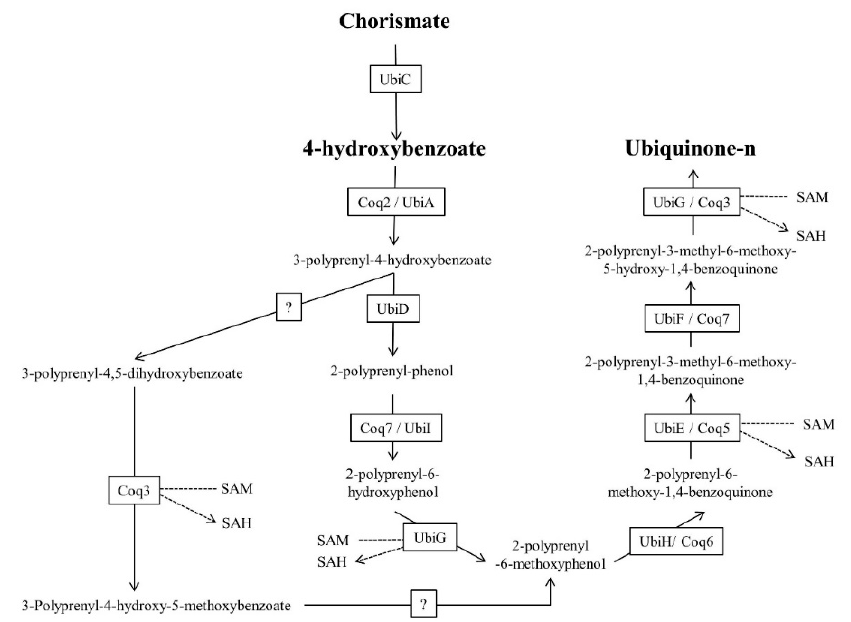
Figure 7. Scheme of ubiquinone biosynthesis. UQ biosynthesis from 4-hydroxybenzoate. In the figure depicting the metabolic pathways, the transformation of the cofactor SAM to S-adenosyl- l -homocysteine (SAH) for methylation is indicated. UbiC. Chorismate-pyruvate lyase, EC: 4.1.3.40; UbiA / Coq2. EC: 4-Hydroxybenzoate polyprenyltransferase, 2.5.1.39; UbiD. 4-Hydroxy-3-polyprenylbenzoate decarboxylase, EC: 4.1.1.98; Coq7 / UbiI. 2-Polyprenylphenol 6-hydroxylase, EC: